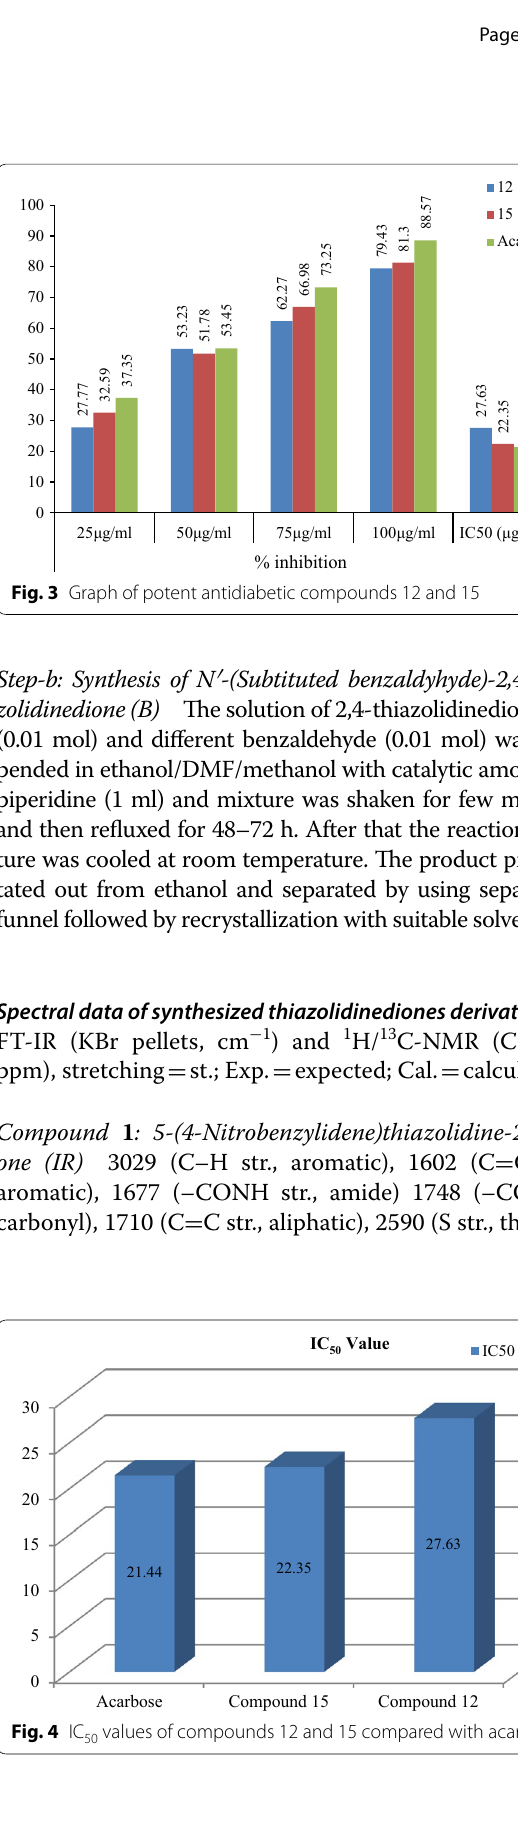
Fig. 4 IC 50 values of compounds 12 and 15 compared with